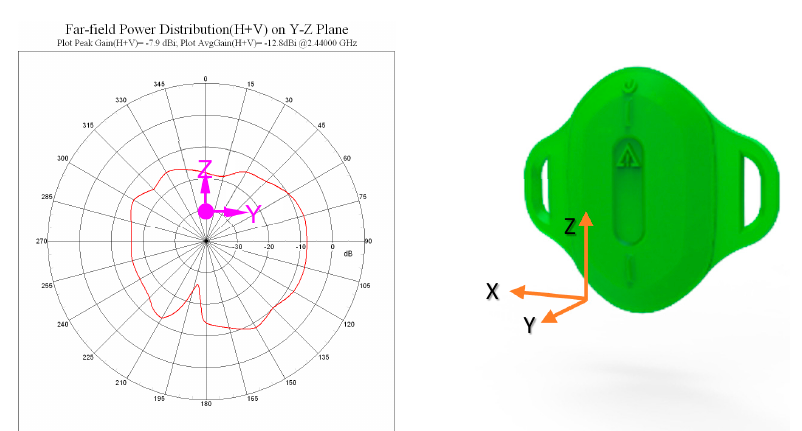
Figure 3. The radiation far-field power distribution of the BLE Tag. ( a ) The X-Y plane; ( b ) the X-Z plane; ( c ) the Y-Z plane; and ( d ) the coordinate axis directions.